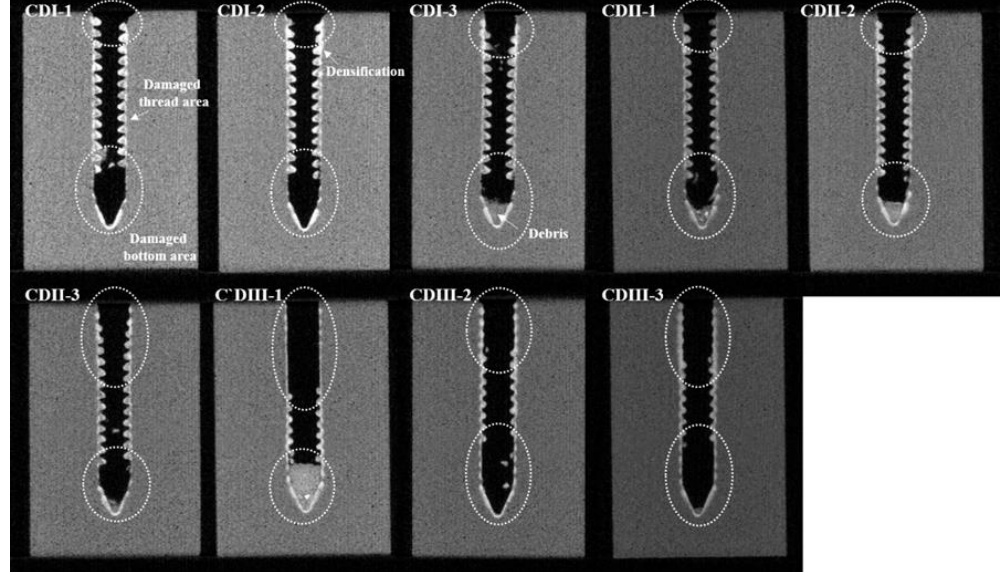
Figure 10. Cross sectional images of the artificial bone (grade 20) with the screw removed after the pullout test.